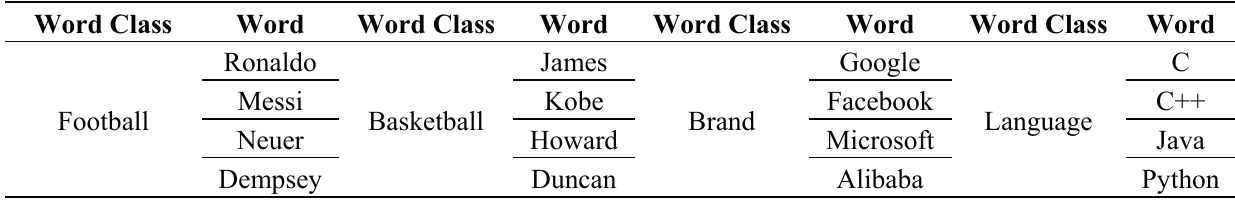
Table 1. Word classes and their corresponding words.